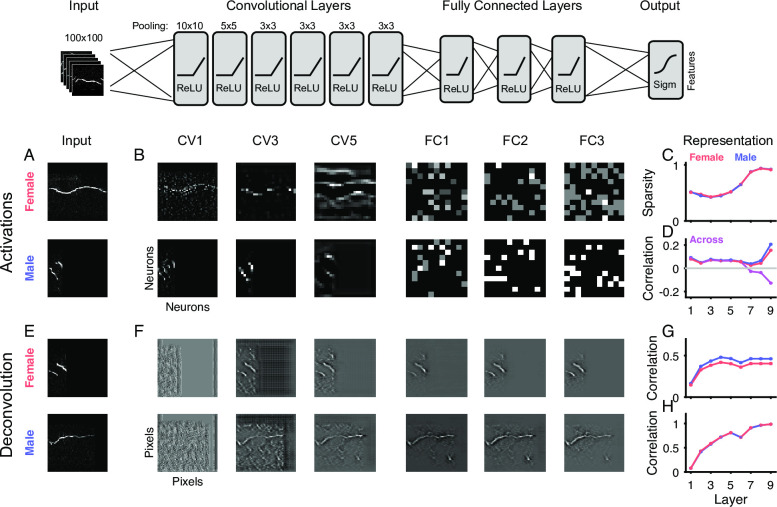
Structural analysis of network activity and representation.Across the layers of the network (top, columns in B/F) the activity progressively dissociated from the image level (compare A and B) (left, A/E). The stimuli (A, samples, top: female; bottom: male) are initially encoded spatially in the early convolutional layers (B, left, CV), but progressively lead to more general activation. In the fully connected layers (B, right, FC), the representation becomes non-spatial. Concurrently, the sparsity (C) and within-sex correlation between FC representations increases (D, red/blue) towards the output layer, while across-sex correlation decreases (D, purple). The average correlation, however, stays limited to ~0.2, and thus the final performance is only achieved in the last step of pooling onto the output units. Using deconvolution [29], the network representation was also studied across layers. The representation of individual stimuli (E) became more faithful to the original across layers (F, from left to right, top: female, bottom: male sample). Correlating the deconvolved stimulus with the original stimulus exhibited a fast rise to an asymptotic value (G). In parallel, the similarity of the representation between the neurons of a layer improved through the network (H). In all plots in the right column, the error bars indicate 2 SEMs, which are vanishingly small due to the large number of vocalizations/neurons each point is based on.